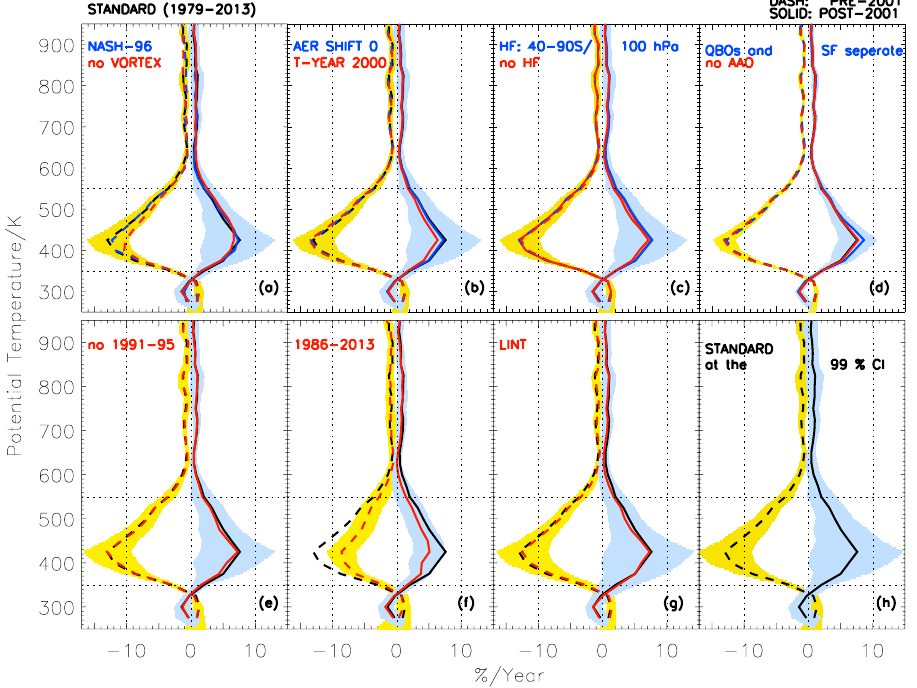
Figure 2. Vertical structure of Antarctic ozone recovery: ( a ) The ozone trends estimated from ozonesonde data in the Antarctic vortex in spring (SON) with ≥ 65° S EqL criterion (“standard”, black cures), Nash et al . 20 vortex criterion (“Nash-96”, blue curves) and without considering the vortex boundaries (“no VORTEX”, red curves) for the 1979–2001 (dash) and 2001–2013 (solid) periods. The break year 2001 corresponds to the year of maximum stratospheric chlorine in the Polar Regions. (b) Trends estimated with various input scenarios, where the blue curves (“AER SHIFT 0”) represent those found without the aerosol time lag and the red curves (“T–YEAR 2000”) represent the analysis performed by changing the break-year to 2000. (c) Trends estimated with a different latitude range for the heat flux data (blue curves) and without the heat flux term entirely are also shown (red curves). In all plots ( a – c ) the standard estimate (black curves) and its uncertainty at the 95% level (shaded areas) are shown. (d) Trend computed without the Antarctic Oscillation (AAO) term and shaded areas represent its uncertainty at the 95% level (red curves). Trend computed using the solar flux (SF) and Quasi-biennial Oscillation (QBO) terms separately (blue curves) instead of coupling SF and QBO as for the standard scenario. (e) Trend computed without the 1991–1995 data (red curves) and shaded areas represent its uncertainty at the 95% level. (f) Trend estimated without the 1979–1985 data (red curves) and shaded areas represent its uncertainty at the 95% level. (g) Trend estimated without using any regression terms, but with the linear terms (“LINT”); shaded areas represent its uncertainty at the 95% level. (h) Standard scenario with its uncertainty at the 99% level. In all plots ( a – h ) the horizontal dotted lines represent 350 K (~12 km) and 550 K (~22 km) altitudes and vertical dotted lines represent − 10%/year and